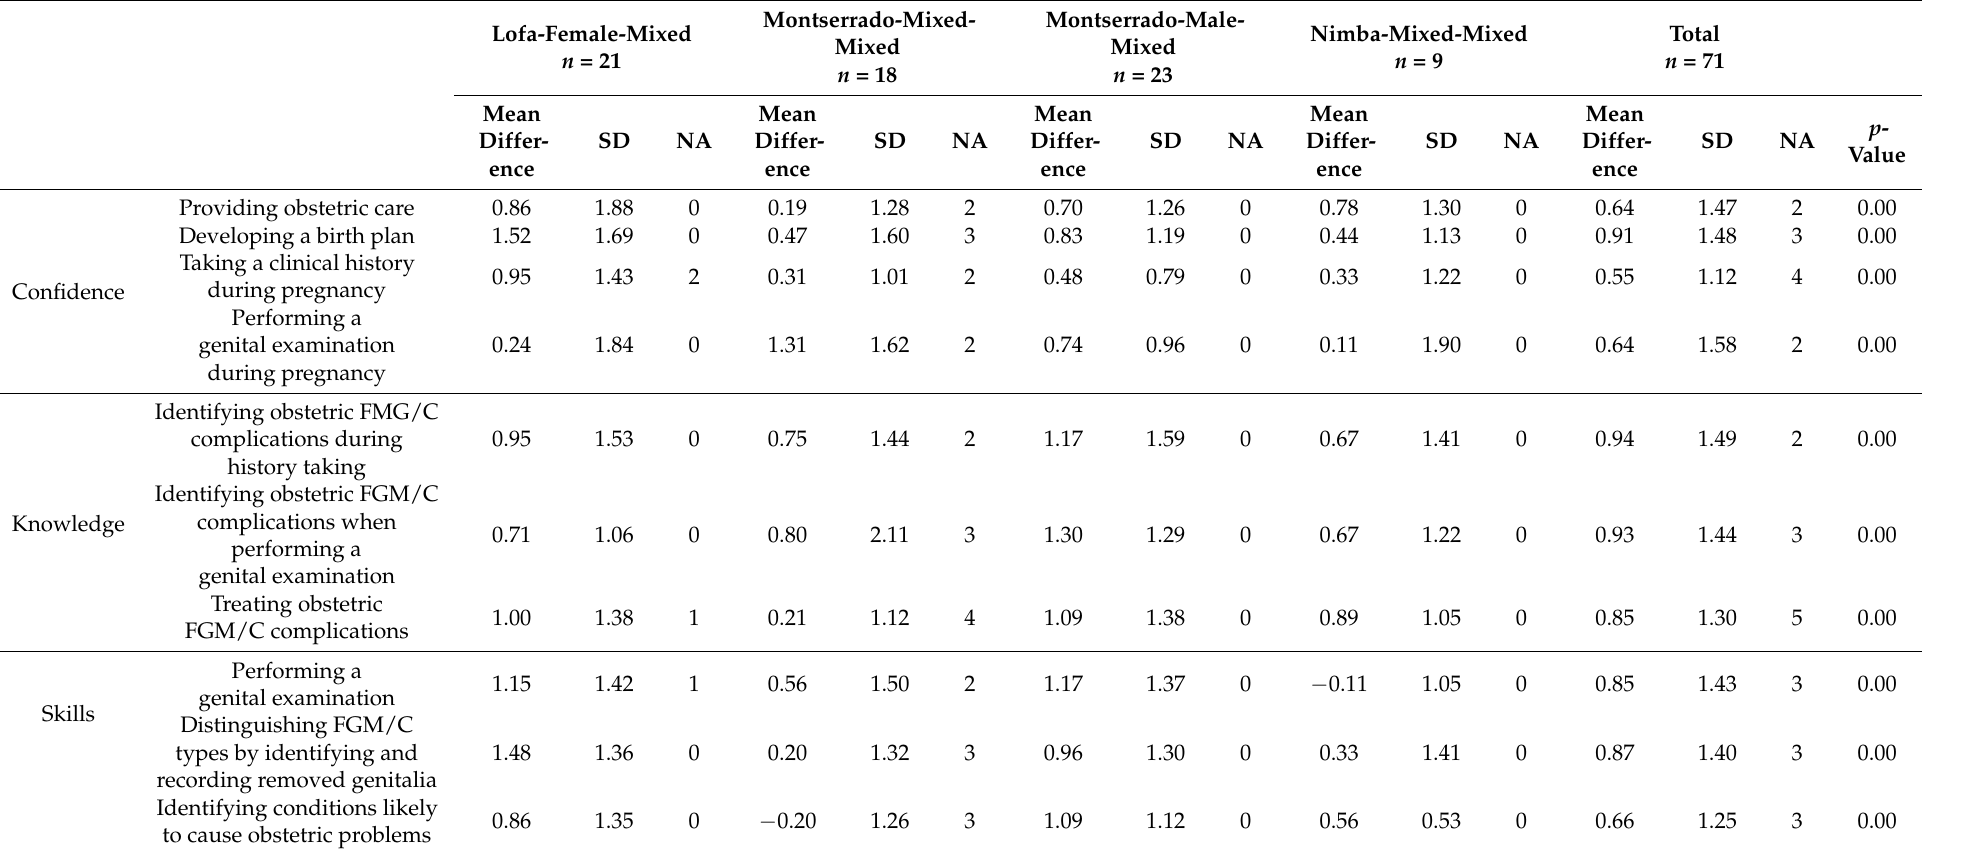
Table 4. Changes in trainees’ self-perceived confidence, knowledge, and skills on care provision to FGM/C survivor post- vs. pre-training. Lofa-Female-Mixed n = 21